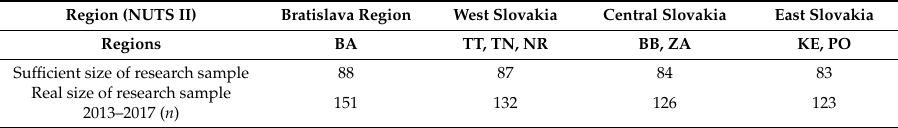
Table 2. Determination of research sample for individual Slovak regions. Region (NUTS II) Bratislava Region BA TT, TN, NR